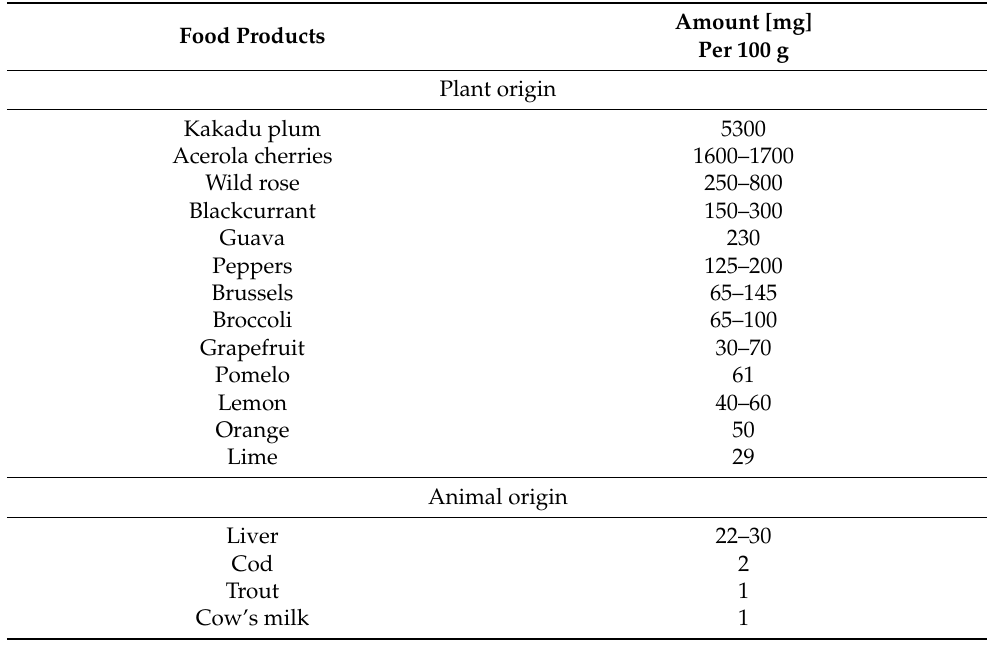
Table 1. The amount of ascorbic acid in basic food products with the greatest levels [8–11].